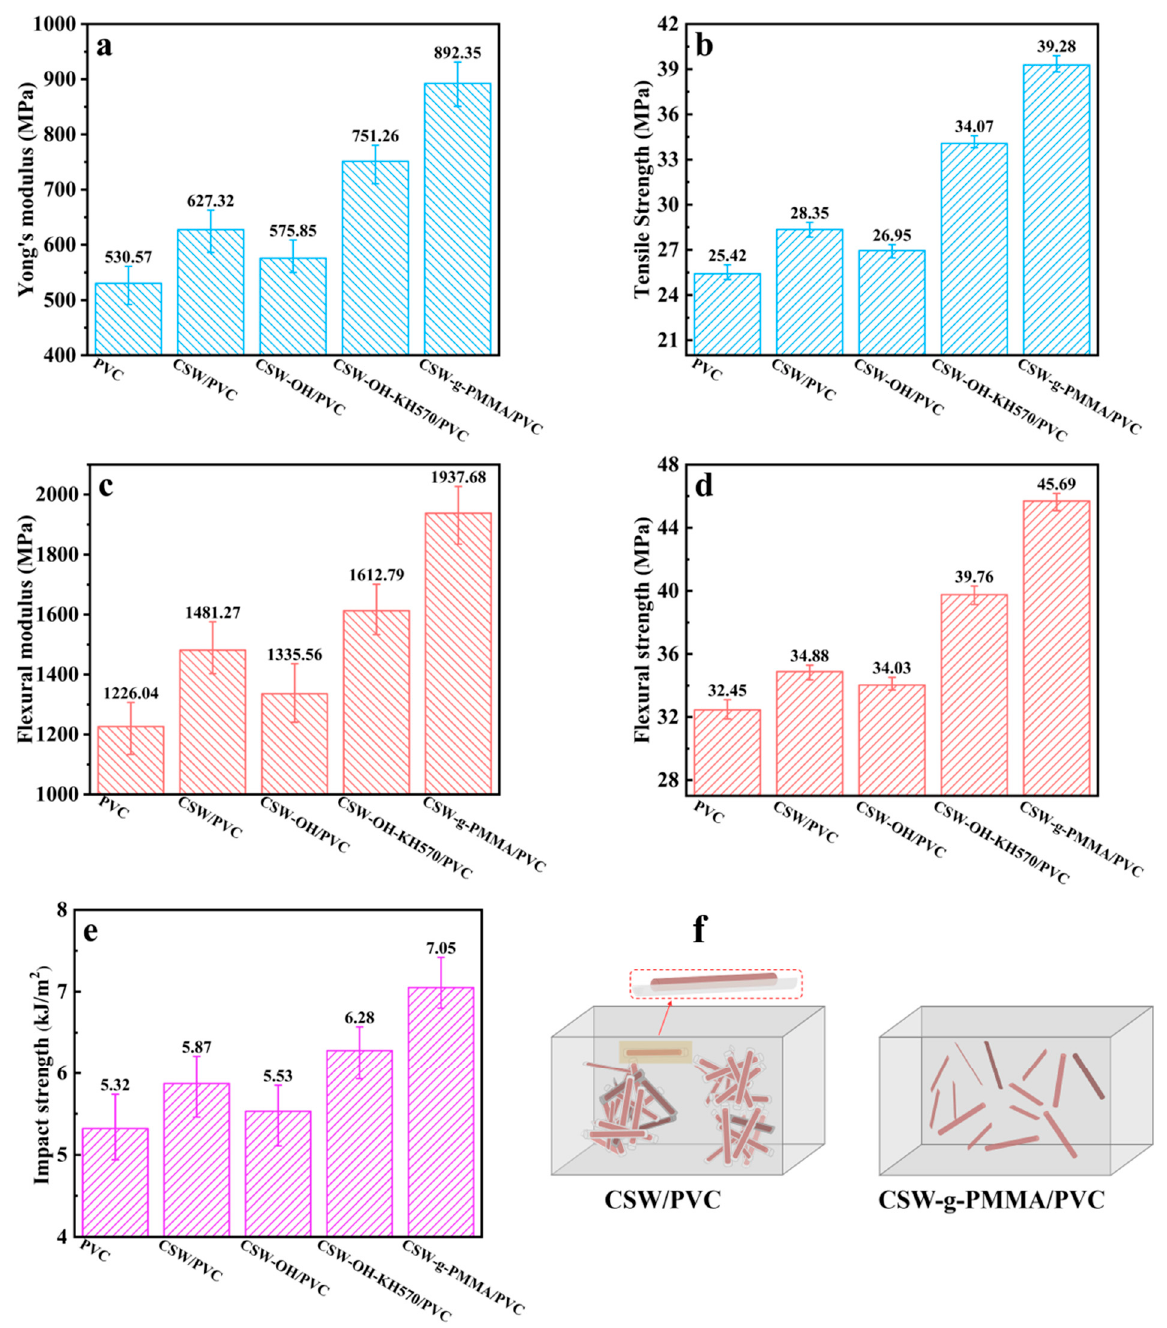
Figure 7. The mechanical properties of ( a ) Young’s modulus, ( b ) tensile strength, ( c ) flexural modulus, ( d ) flexural strength, and ( e ) impact strength for pure PVC and composites of untreated CSW/PVC, CSW ‐ OH/PVC, CSW ‐ OH ‐ KH570/PVC, and CSW ‐ g ‐ PMMA/PVC, respectively; ( f ) schematic diagram of the dispersion of untreated CSWs and CSW ‐ g ‐ PMMA in the PVC matrix, respectively.